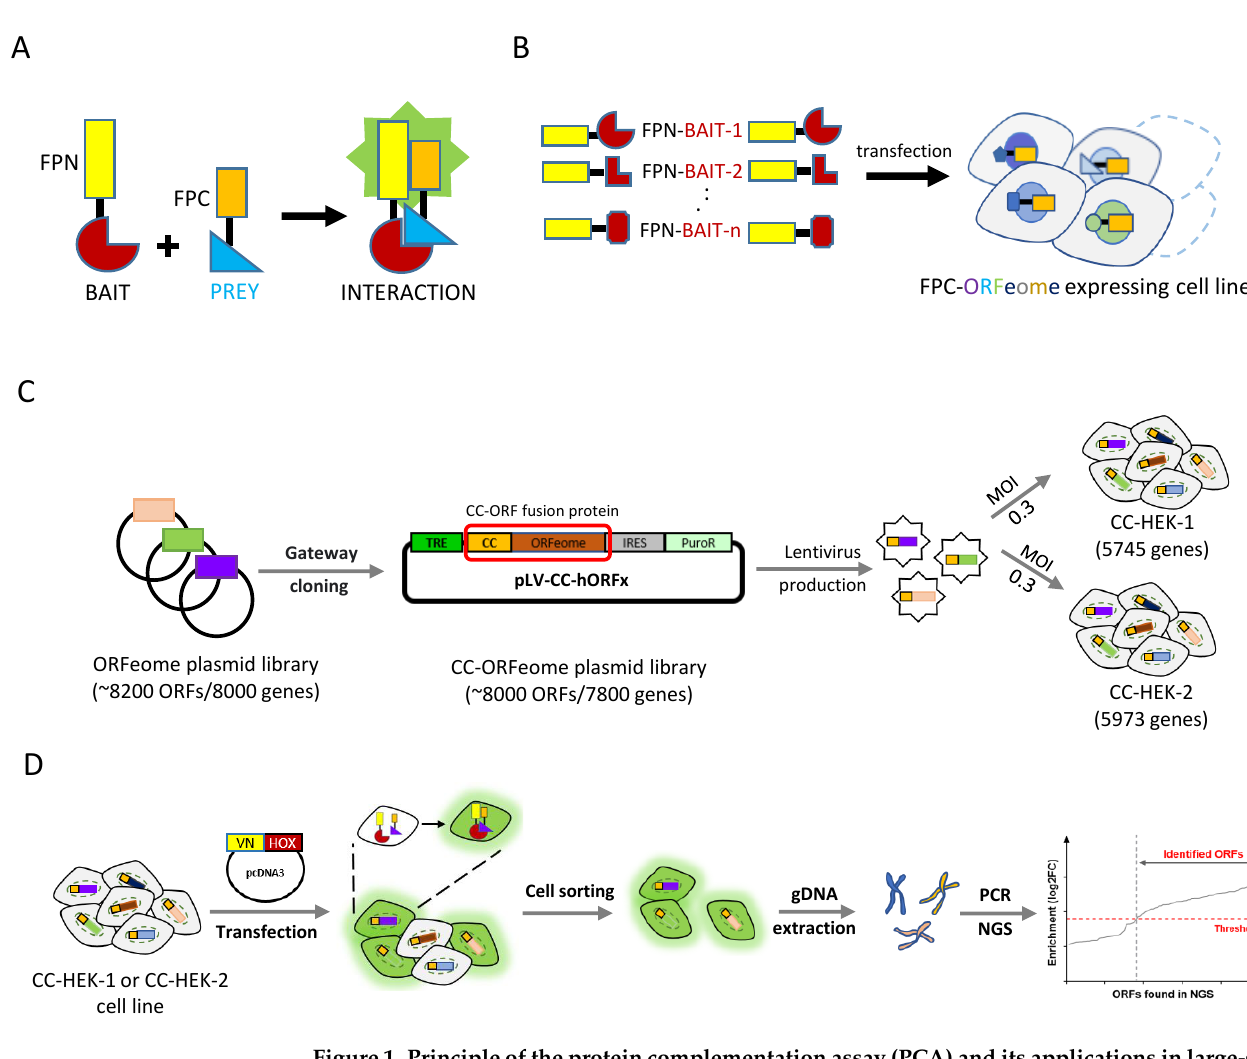
Figure 1. Principle of the protein complementation assay (PCA) and its applications in